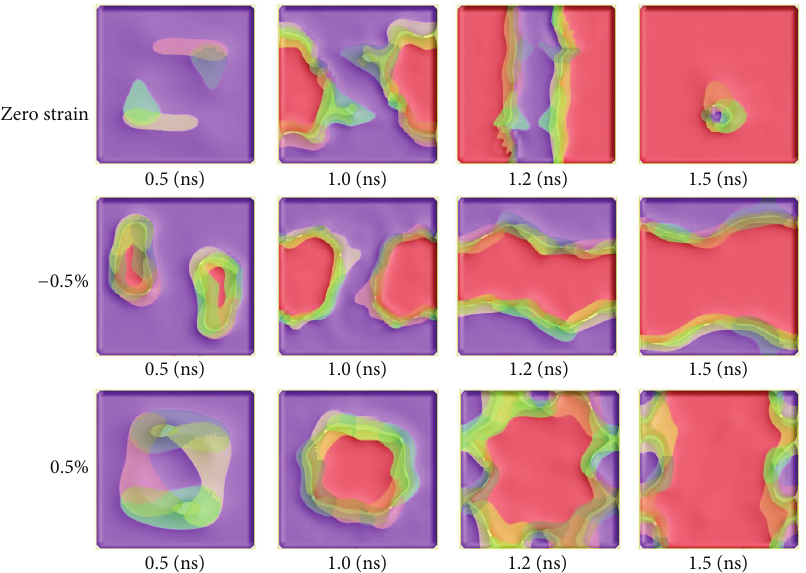
Figure 4: Magnetic domain evolutions with different misfit substrate strains during the magnetization